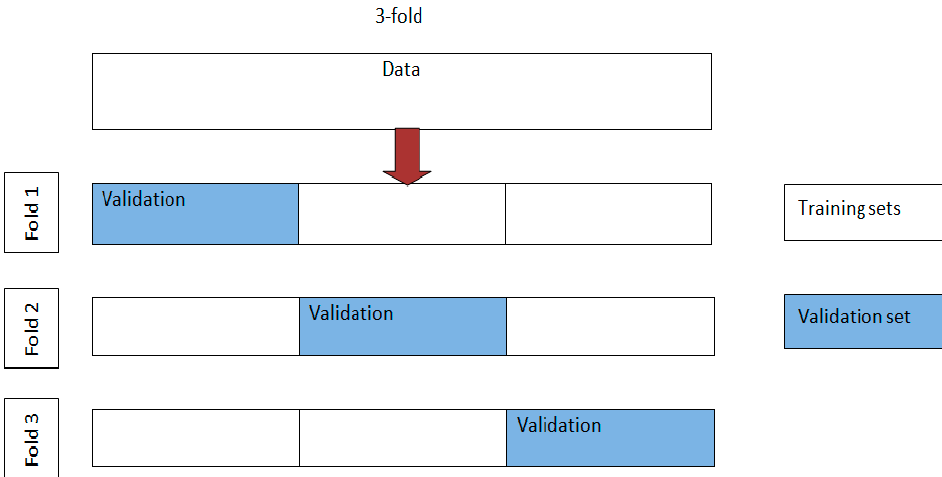
Figure 3. Three-fold cross-validation.